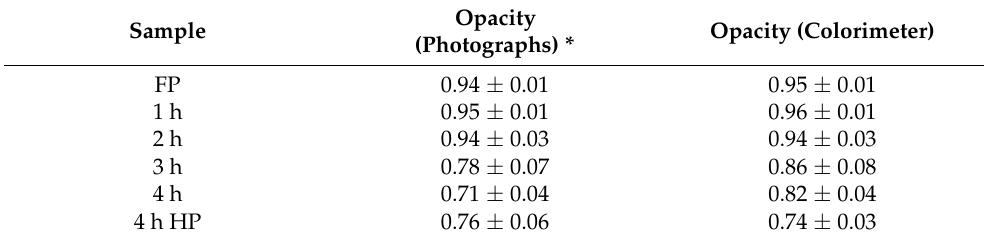
Table 2. Effect of treatment time on samples’ opacity.